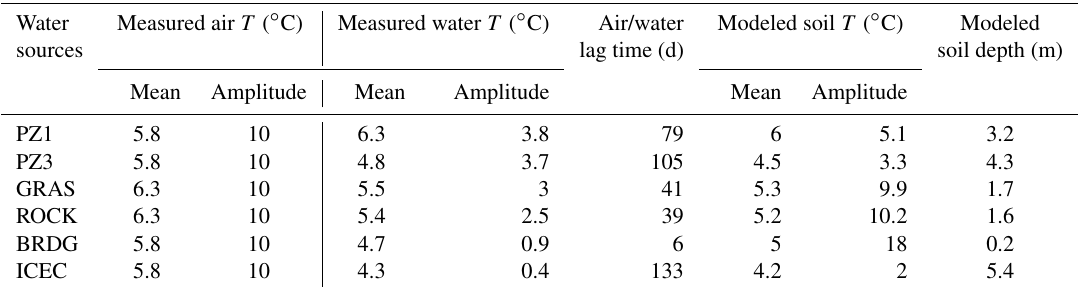
Table 2. Characteristics of the sinusoidal air and water temperatures used for the soil temperature model, and characteristics of the soil temperature at the estimate depth corresponding to the water